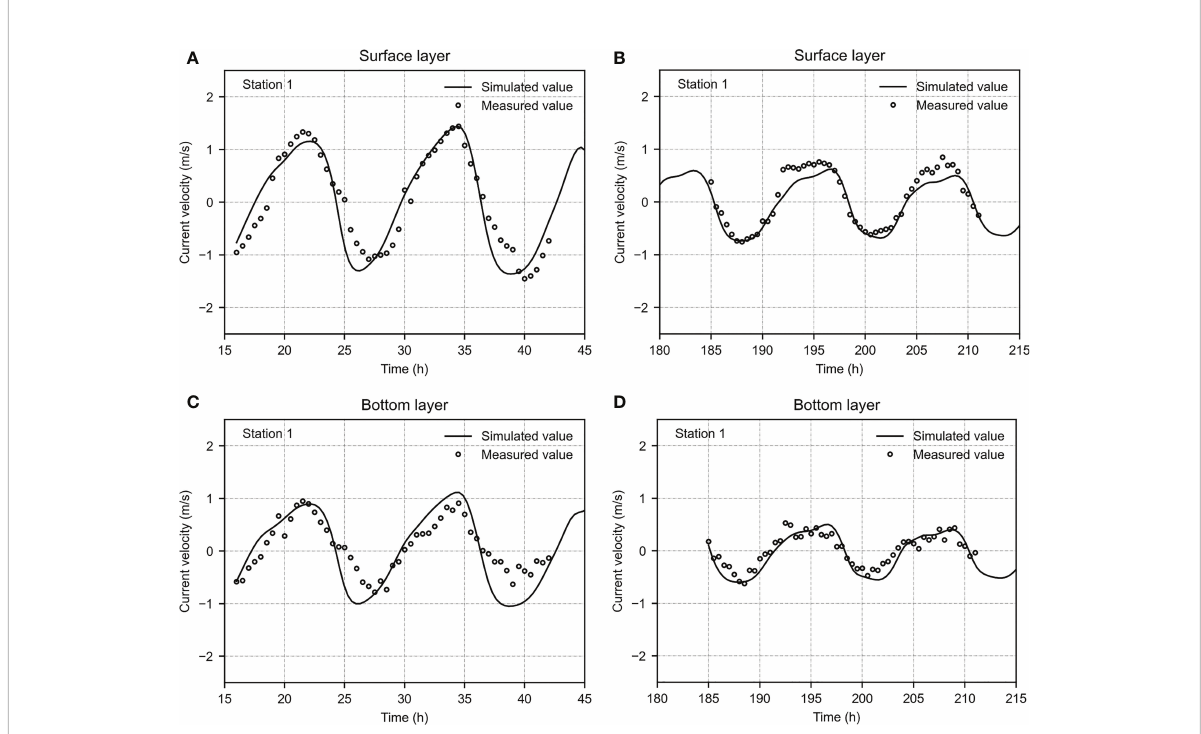
FIGURE 6 Validation of surface & bottom fl ow velocity during spring & neap tide at Station 1. (A) Surface current velocity at Station 1 during spring tide. (B) Surface current velocity at Station 1 during neap tide. (C) Bottom current velocity at Station 1 during spring tide. (D) Bottom current velocity at Station 1 during neap